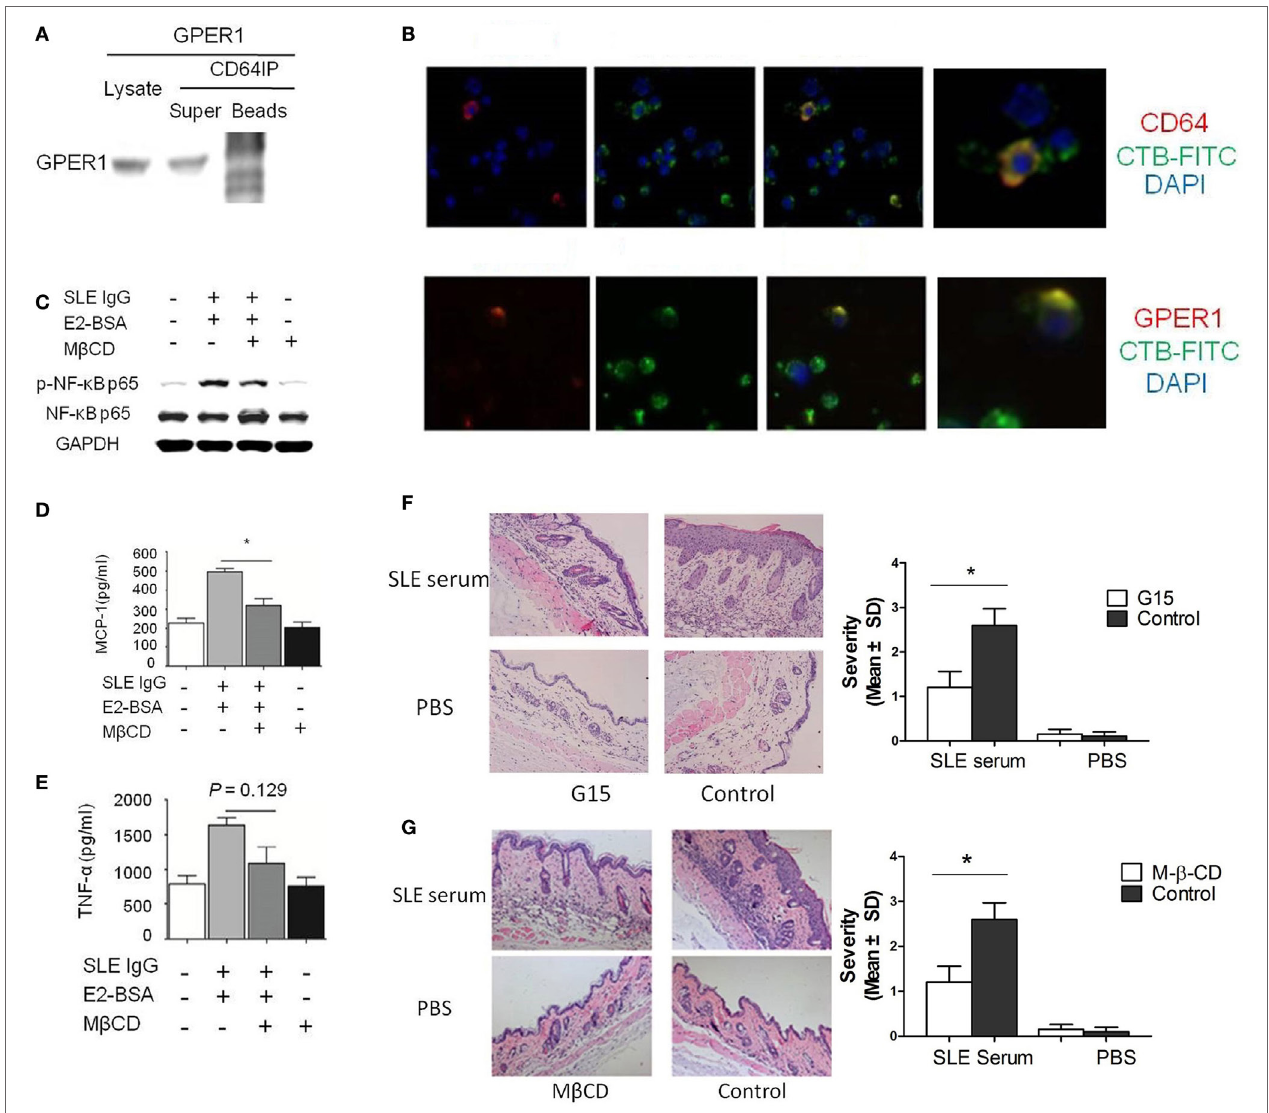
FigUre 4 | E2 promotes activation of systemic lupus erythematosus (SLE) IgG-induced monocytes and skin inflammation through lipid rafts. (a) Relationship of G protein-coupled estrogen receptor 1 (GPER1) and CD64 measured by western blot and immunoprecipitation in Raw264.7 cells. (B) Immunofluorescent staining of GPER1 and lipid rafts or CD64 and lipid rafts on monocytes treated with SLE IgG. (c) Western blot-measured levels of p-NF- κ B p65/NF- κ B p65 in Raw264.7 cells treated with medium, SLE IgG + E2-BSA, SLE IgG + E2-BSA + methyl- β -cyclodextrin (M β CD), or M β CD for 30 min. (D,e) CBA-measured levels of MCP-1 (D) or TNF- α (e) in supernatants of Raw264.7 cells treated with medium, SLE IgG + E2-BSA, SLE IgG + E2-BSA + M β CD, or M β CD for 24 h. (F) Histopathological photomicrograph and severity of skin inflammation in female C57BL/6 mice treated with or without G15 and sacrificed 3 days after intradermal inoculation of SLE serum. G15 at dose of 2 µg was administered intraperitoneally three times a week for 2 weeks ( n = 10 per group). (g) Histopathological photomicrograph and severity of skin inflammation in female C57BL/6 mice treated with or without M β CD (1 mg/mouse three times a week, i.p., for 2 weeks) sacrificed 3 days after intradermal inoculation of serum (100 µl) from a SLE patient ( n = 8 per group). H&E, original magnification 20 × . * P <